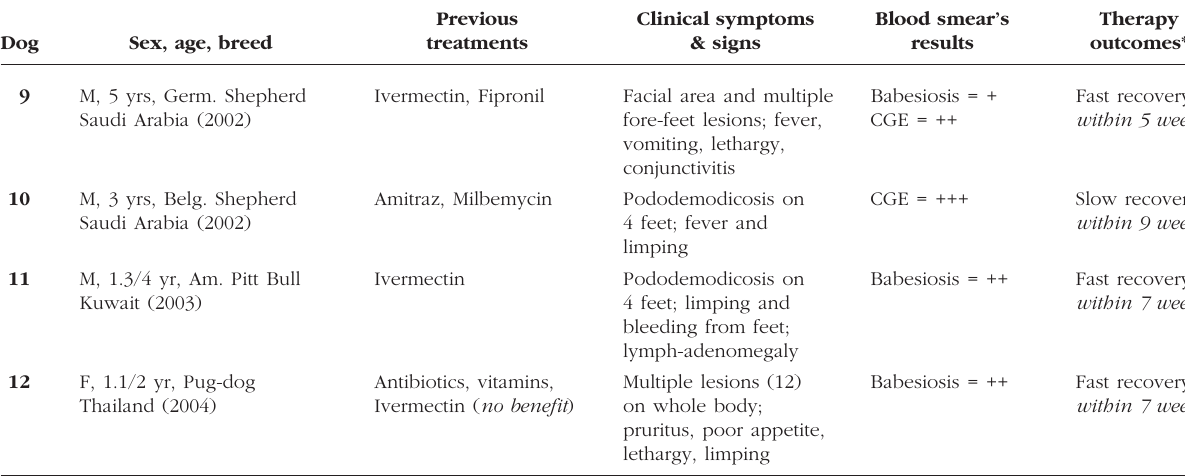
* Babesiosis was treated with imidocarb dipropionate (four injections, one week apart). CGE was treated with doxycycline (os., 21-42 days at 10 mg/kg/day). Infected red (babesiosis) and white (CGE) blood cells: (+): less than 0.03 %; (++): from 0.03 to 0.3 %; (+++): from 0.3 to 3 %; (++++): more than 3 %. Table I. – Signalment, history, clinical findings and results of laboratory tests and therapies in 12 dogs with generalized demodicosis from Italy, Saudi Arabia, Kuwait and